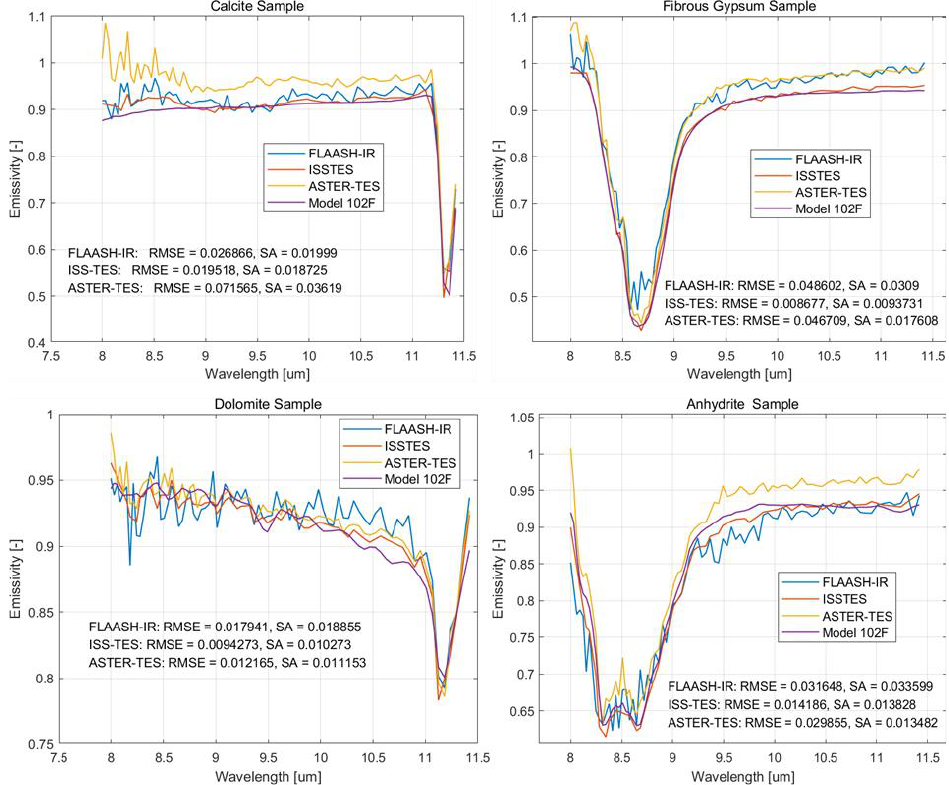
Figure 14. Emissivity quantitative evaluation for the three different methods and a comparison with the reference emissivity spectra measured by the D&P Model 102F spectrometer. the reference emissivity spectra measured by the D&P Model 102F